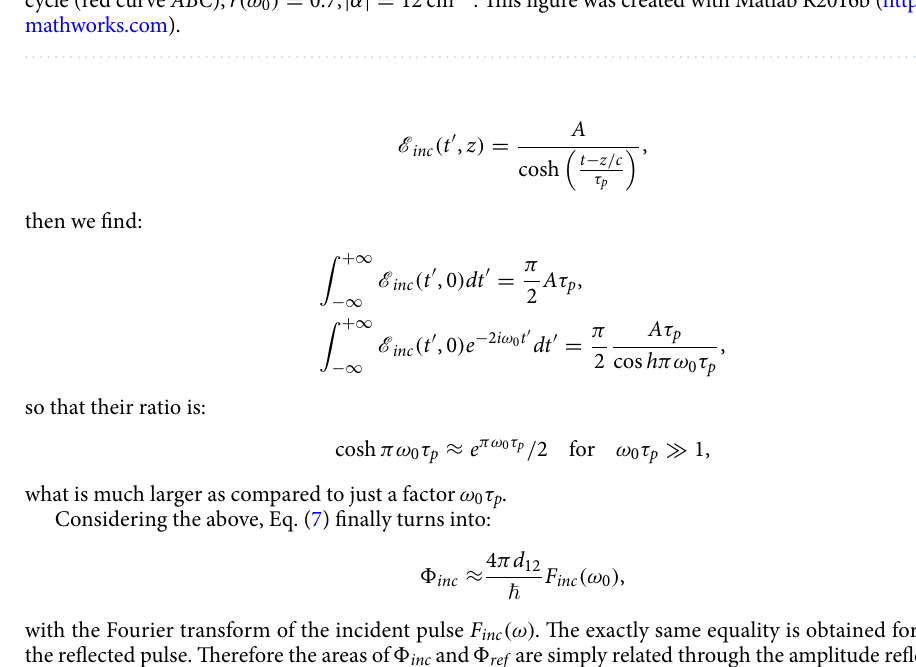
1 . This figure was created with Matlab R2016b (http://www.